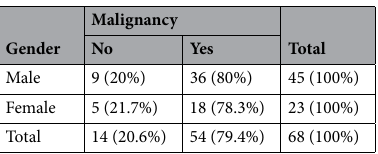
Table 1. A group of 68 patients/gender versus malignancy.